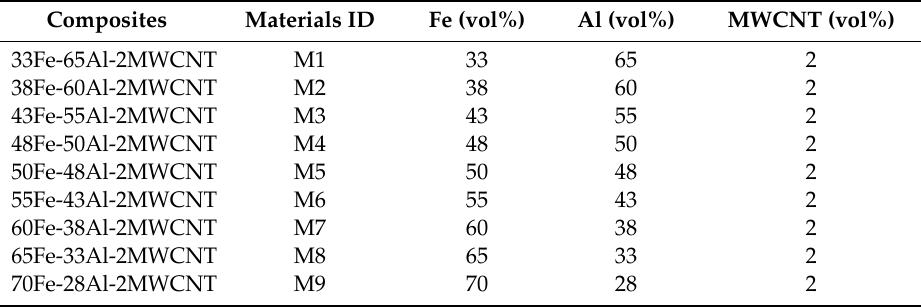
Table 1. Element volume ratio in Fe-Al-MWCNT hybrid nanocomposite materials. MWCNT: multi-walled carbon nanotube.